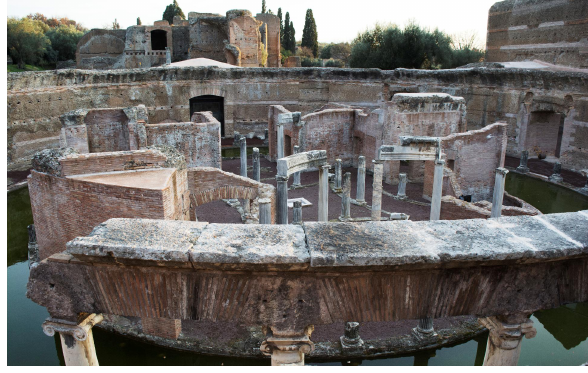
Figure 1. Overall view of the Maritime Theatre The spaces of the Maritime Theatre perform the same function of those of a Roman domus (atrium, tablinum,